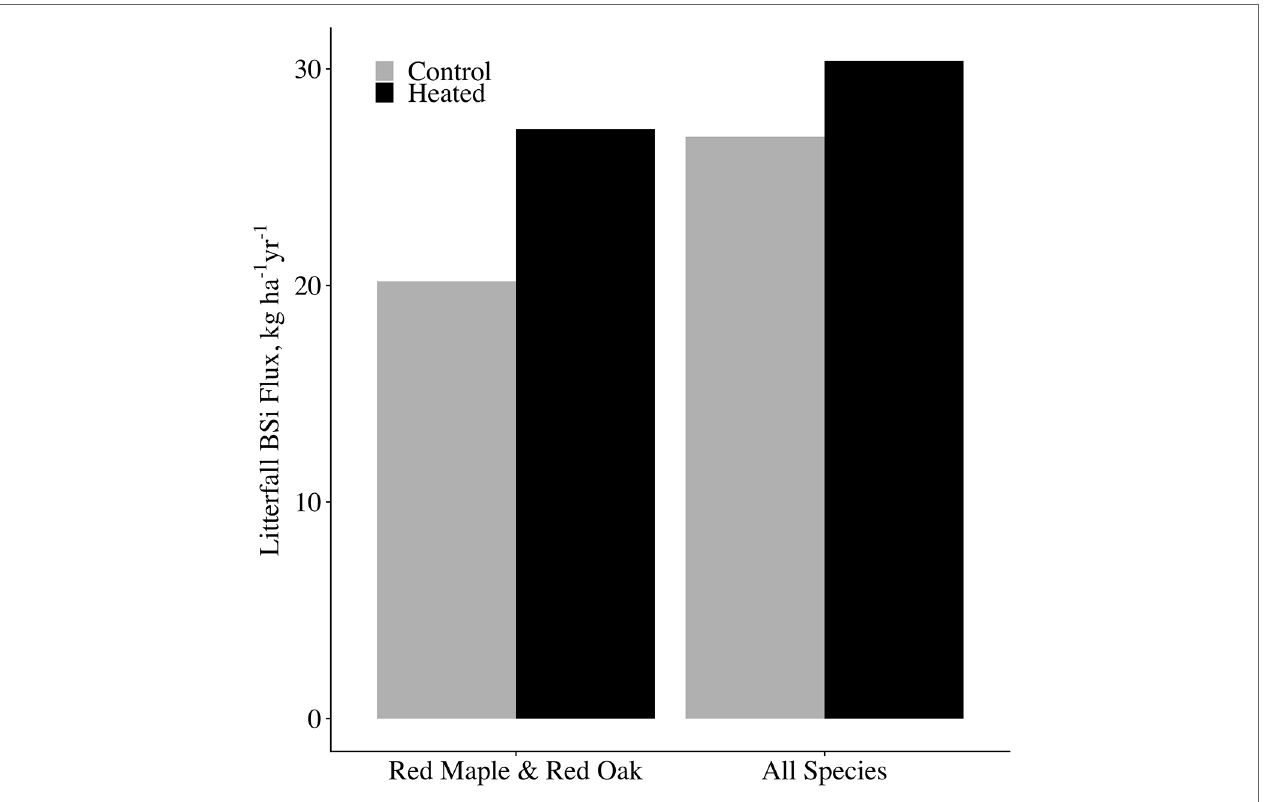
FIGURE 7 | Annual canopy BSi production and release. A comparison between control and heated plot annual BSi uptake (and thus release through fine litterfall). BSi fluxes for each plot are shown for the species analyzed in this study only (red maple and red oak), as well as for our estimated of all species combined in each